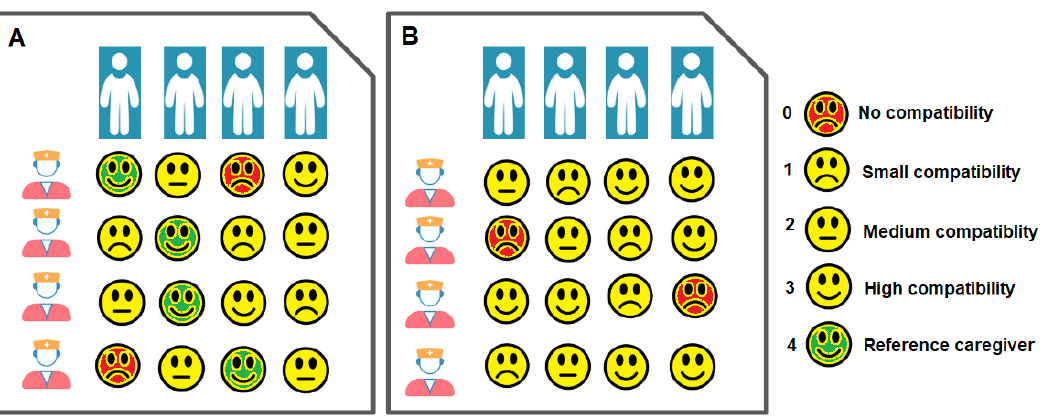
Figure 5. Illustration of the hard ( A ) and low ( B ) compatibility